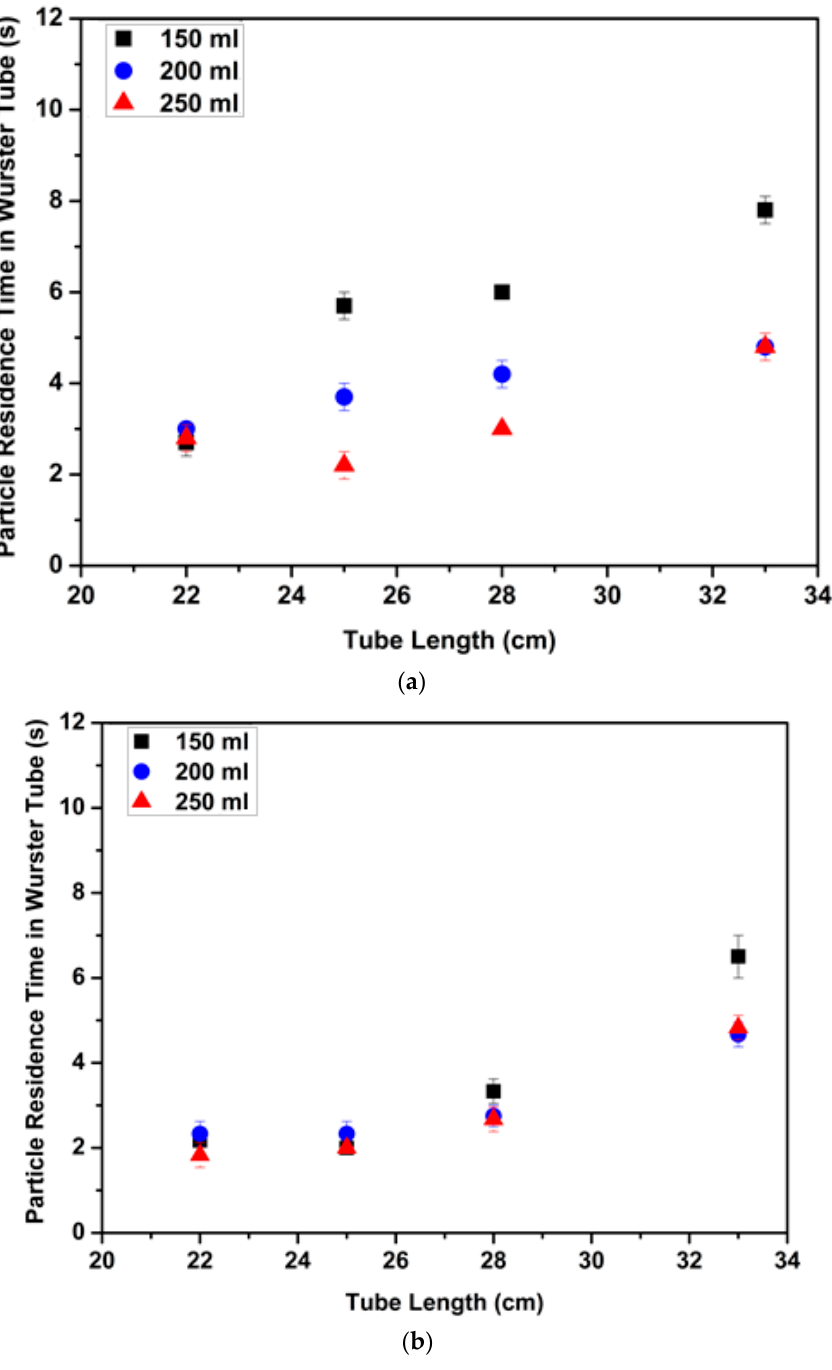
Figure 10. Variation of aerogel particle residence time in the narrow Wurster tube with batch volume, tube length for ( a ) 1 cm partition gap height; ( b ) 2 cm partition gap height.